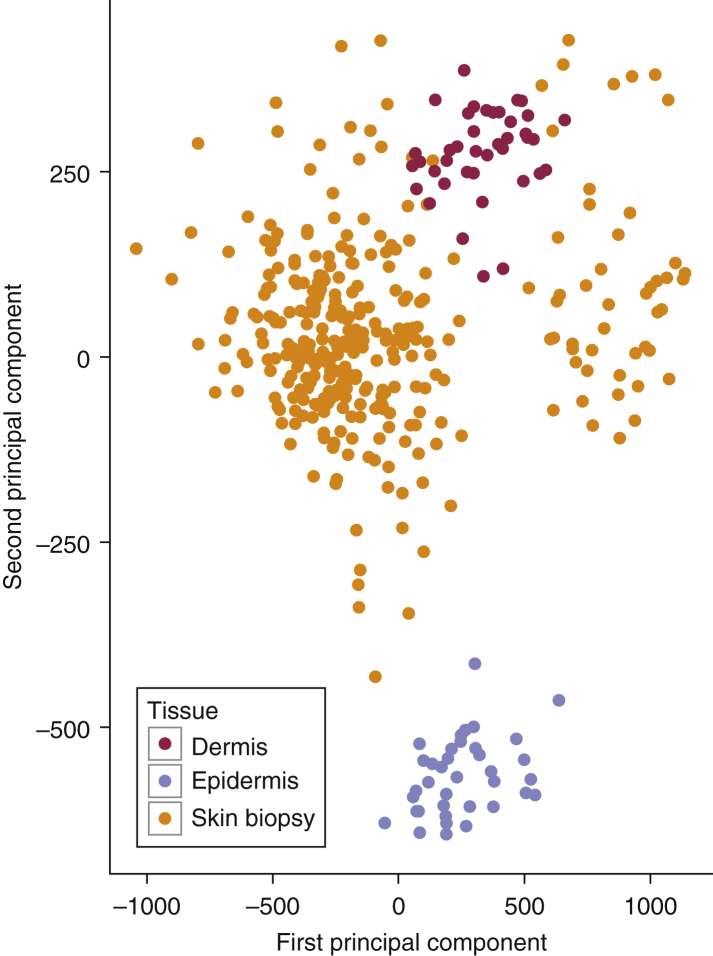
Global DNA methylation profiles and skin tissue specificity. First two principal components colored by layer specificity; red for dermal tissue, blue for epidermal tissue, and yellow for our data (see the legend).